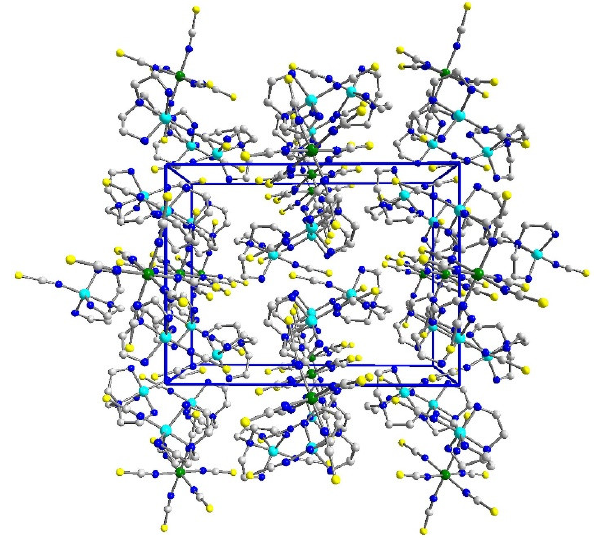
Figure 6. Packing of 3 along the a axis shows columns of the copper and nickel units.